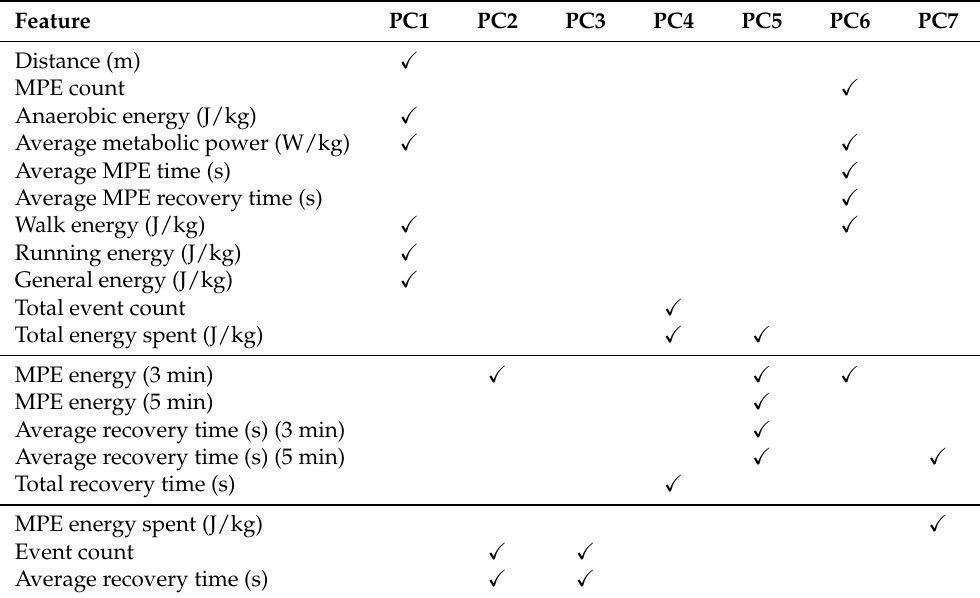
Figure 6. Analysis of K-means clustering with WCSS method and PCA component inspection. The optimal number of clusters is chosen using an elbow method. The resulting cluster number is 3, with the number of PCA components being 7, which corresponds to 92.8% of the original data variance. Table 2. The most important features (above 0.3) for every PCA